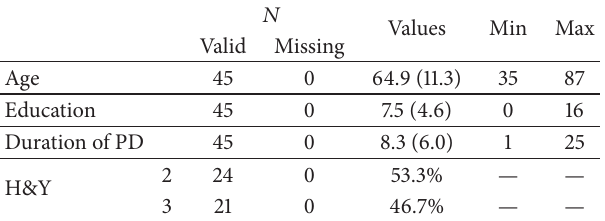
Table 1: Demographic and clinical characteristics of the